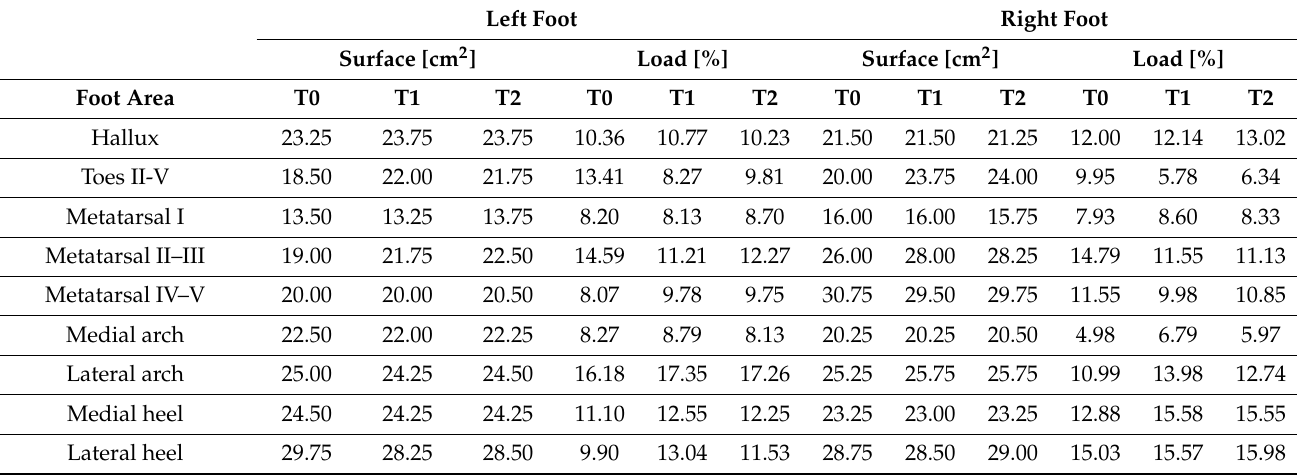
Table 2. Surface and load of foot areas before using the Kinesiology Taping (T0), directly after tapes application (T1) and after tapes removal following monthly using